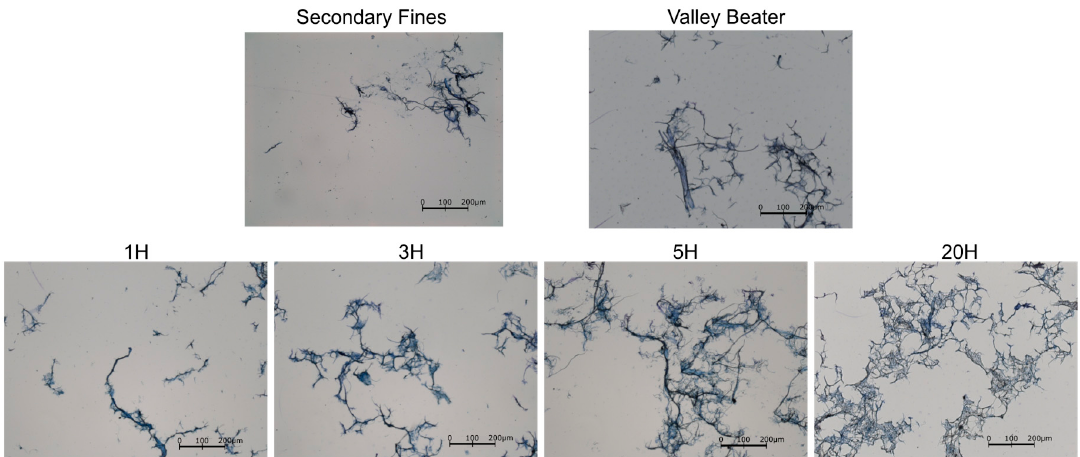
Figure 5. Microscopic Images of the different stained fibrous materials using a combination of tall oil–water emulsion with methylene blue solution and observed with a conventional transmission light microscope (Leica 301-371.010).